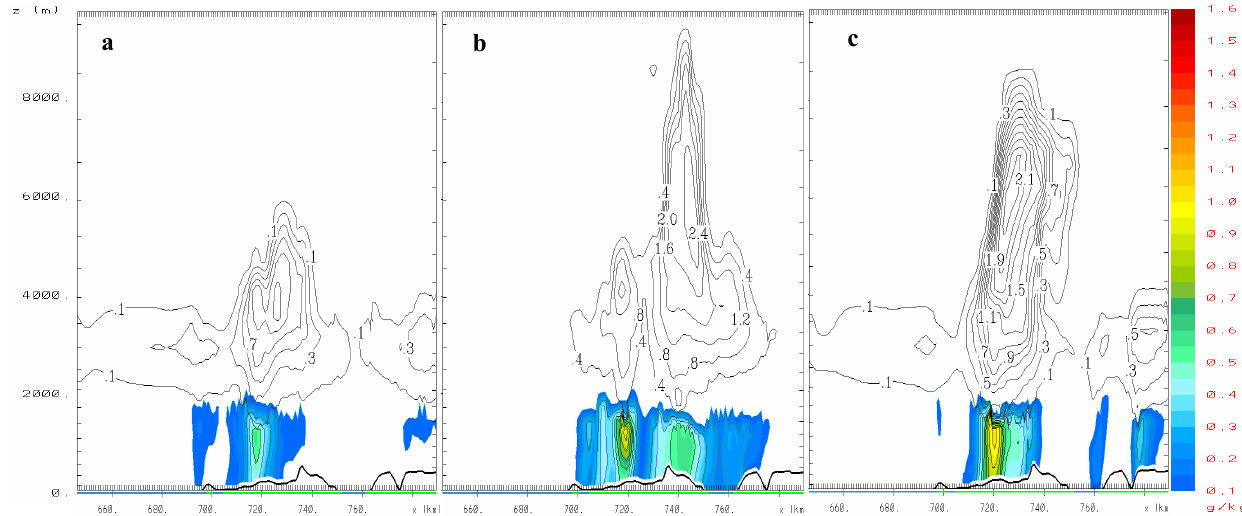
Fig. 11. West to East cross-section of rain mixing ratio (color palette in gkg − 1 ) and ice mixing ratio (red line contours in gkg − 1 ) at the time of highest cloud top over Haifa. (a) 09:00UTC 29 January 2003 assuming 5% hygroscopic dust (EXP1). (b) 10:00UTC 29 January 2003 assuming 20% hygroscopic dust (EXP2). (c) 09:00UTC 29 January 2003 assuming 5% hygroscopic dust and IN × 10 (EXP3). Table 3. Model characteristics for nine aerosol scenarios. Aerosol Cases Aerosol-cloud Aerosol-radiation interaction interaction Case1 (control run)